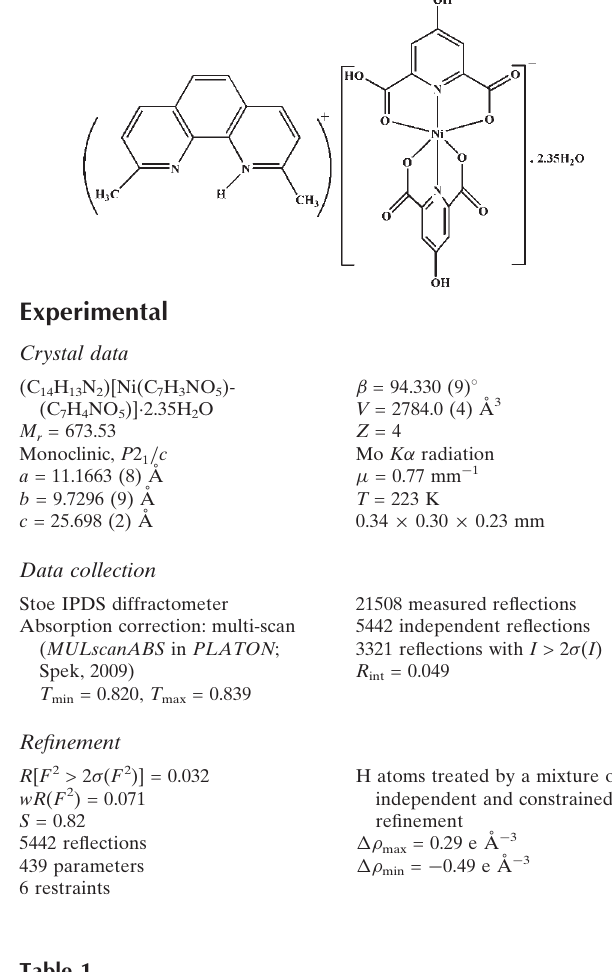
Stoe IPDS diffractometer Absorption correction: multi-scan